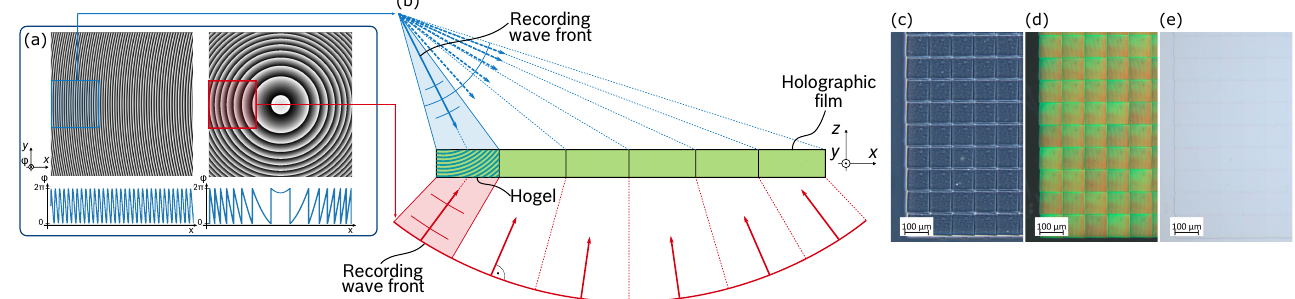
Figure 1. ( a ) Digitally designed phase patterns to define the hologram’s global optical function, including two one-dimensional graphs, outlining the horizontal cross-section of both phase patterns. Segments of the global phase patterns are relayed onto two SLMs, to shape the recording wave fronts. ( b ) Illustration of the vHOE fabrication process by sequential recording of individual Hogels. Microscope images of the recorded vHOE via ( c ) phase-contrast-, ( d ) dark-field- and ( e )